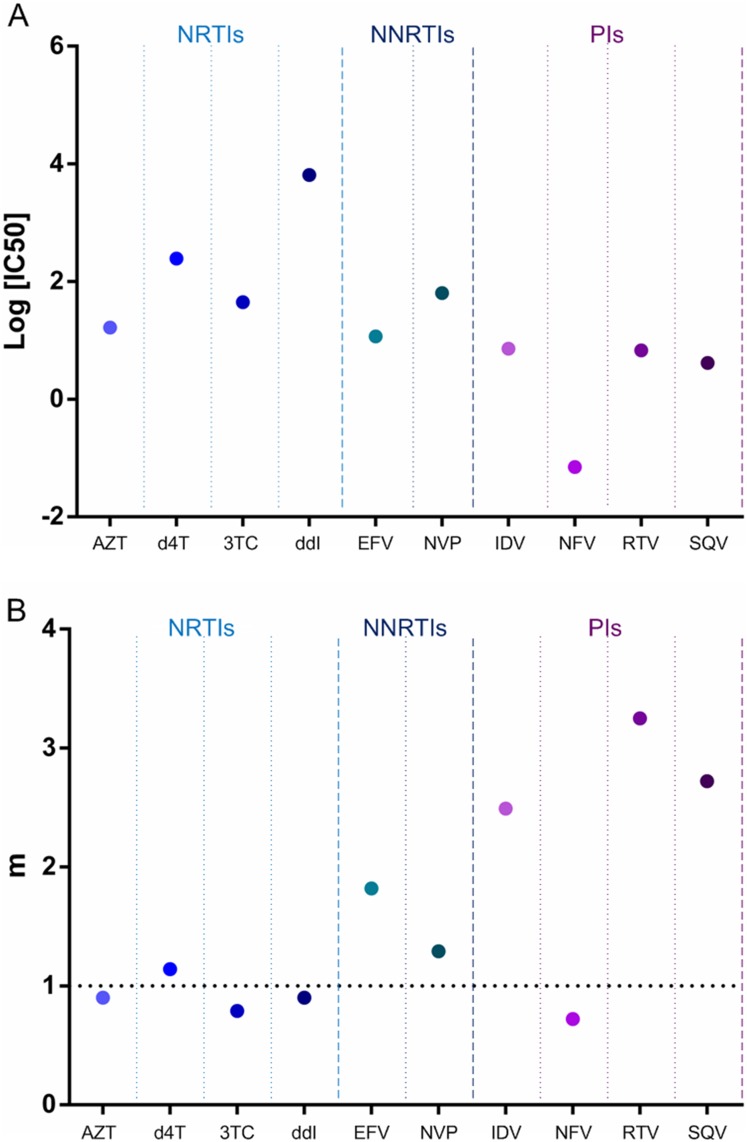
(A) IC50s and (B) slopes of three classes of antiretroviral drugs against HIVNL4-3, as determined during multiple-round infectivity assays.